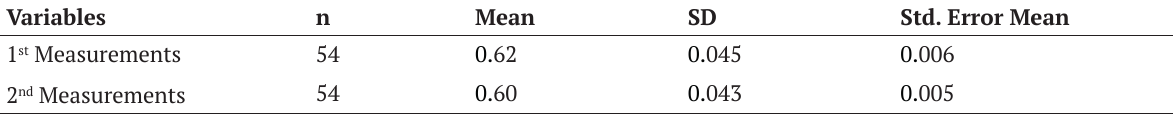
Table 3. Descriptive statistics of measurement values of the experimental group (Paired Samples Statistics) Variables